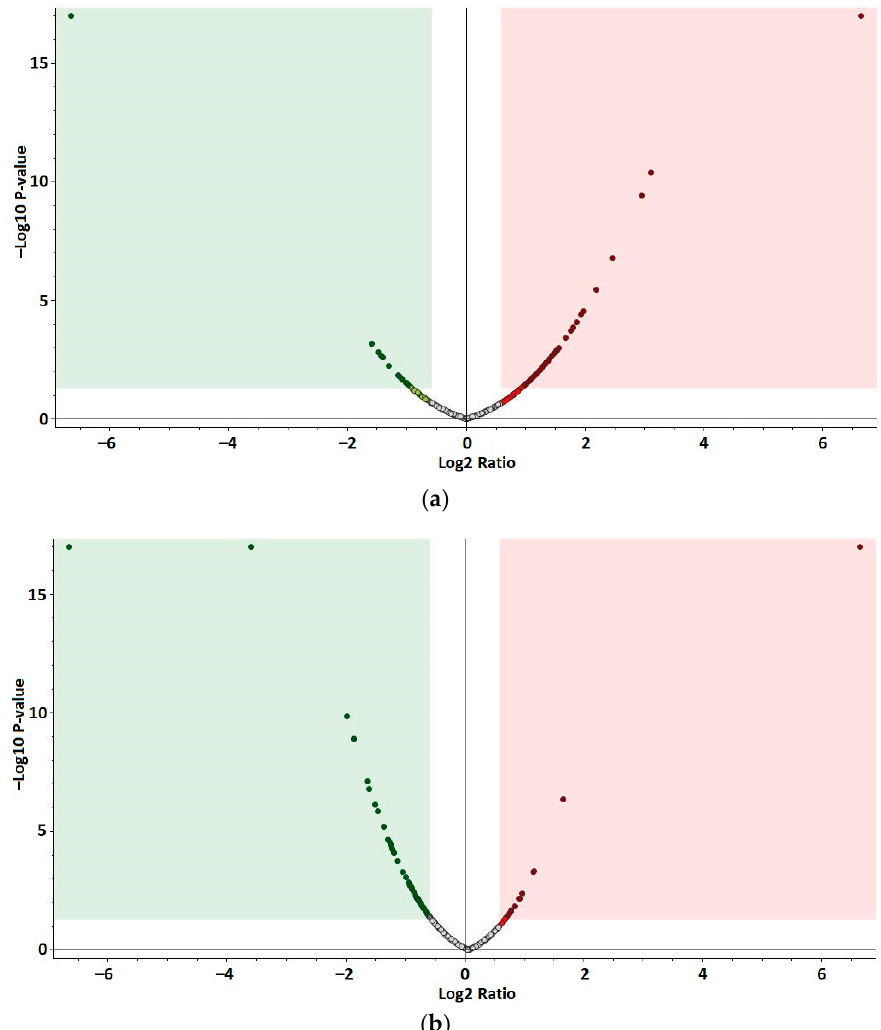
Figure 2. Volcano plots showing differentially abundant proteins in treated yeast samples. The − log10 ( p -value) is plotted against the log2 fold change. Points above the horizontal line (non-axial) present proteins with significantly different abundances ( p -value < 0.05). Points to the left of the vertical line (non-axial) present protein log2 fold changes lower than − 0.58, and points to the right of the vertical line (non-axial) present protein log2 fold changes greater than 0.58. Significantly downregulated and upregulated proteins p value < 0.05) are plotted in the green (left) and red (right) fields, respectively. ( a ) Yeast treated with water extract of fermented Spirulina (SV) vs. yeast treated with water extract of non-fermented Spirulina (NFV). Fold changes of SV/NFV. ( b ) Yeast treated with ethanol extract of fermented Spirulina (SE) vs. yeast treated with the ethanol extract of non-fermented Spirulina (NFE). Fold changes of